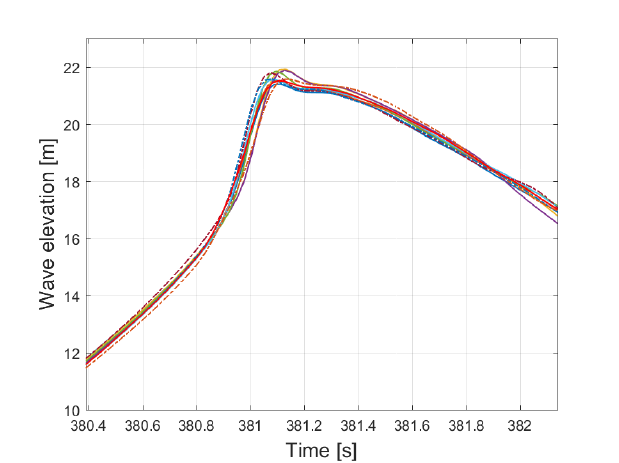
Figure 20. Focused Wave 1 in atmospheric and depressurised condition (50 mbar, red line). Figure based on the same data as a figure in